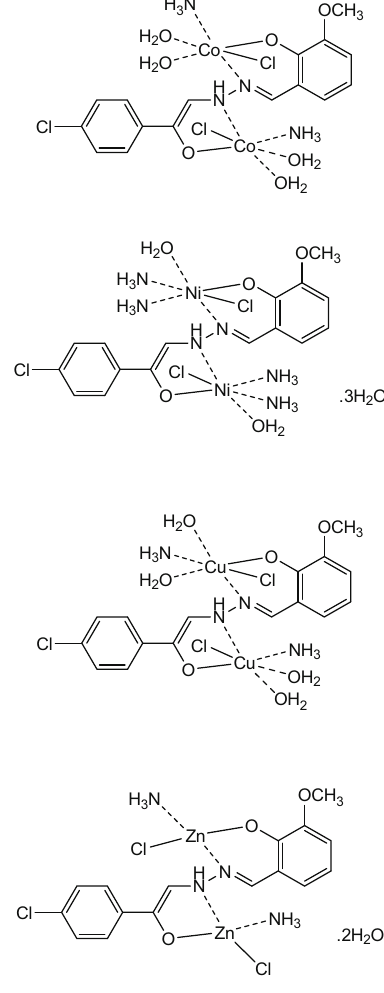
Figure 2: Proposed structures of 2:1 methoxy - diim